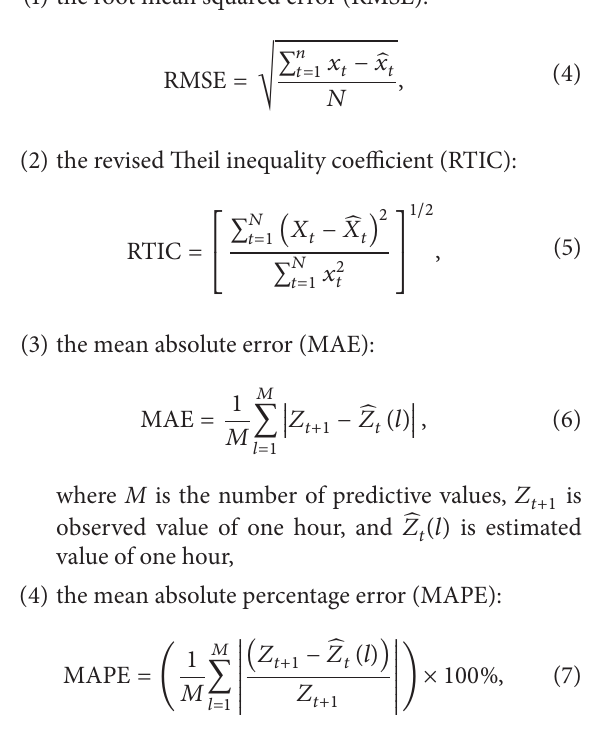
Hotel service attitude